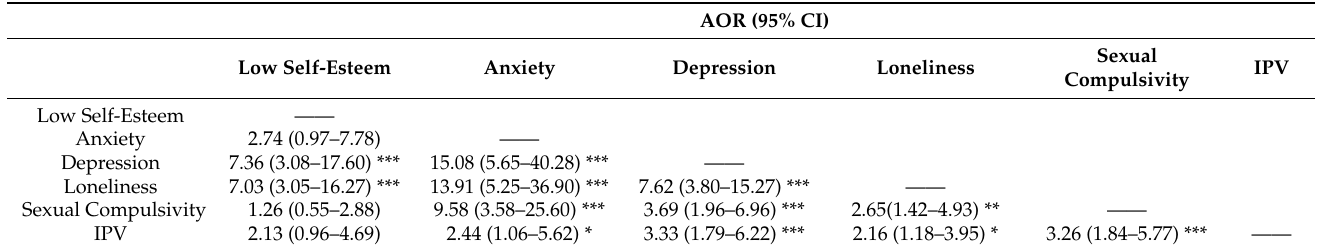
Table 3. Adjusted associations of psychosocial problems among transgender women ( N = 247). AOR (95%